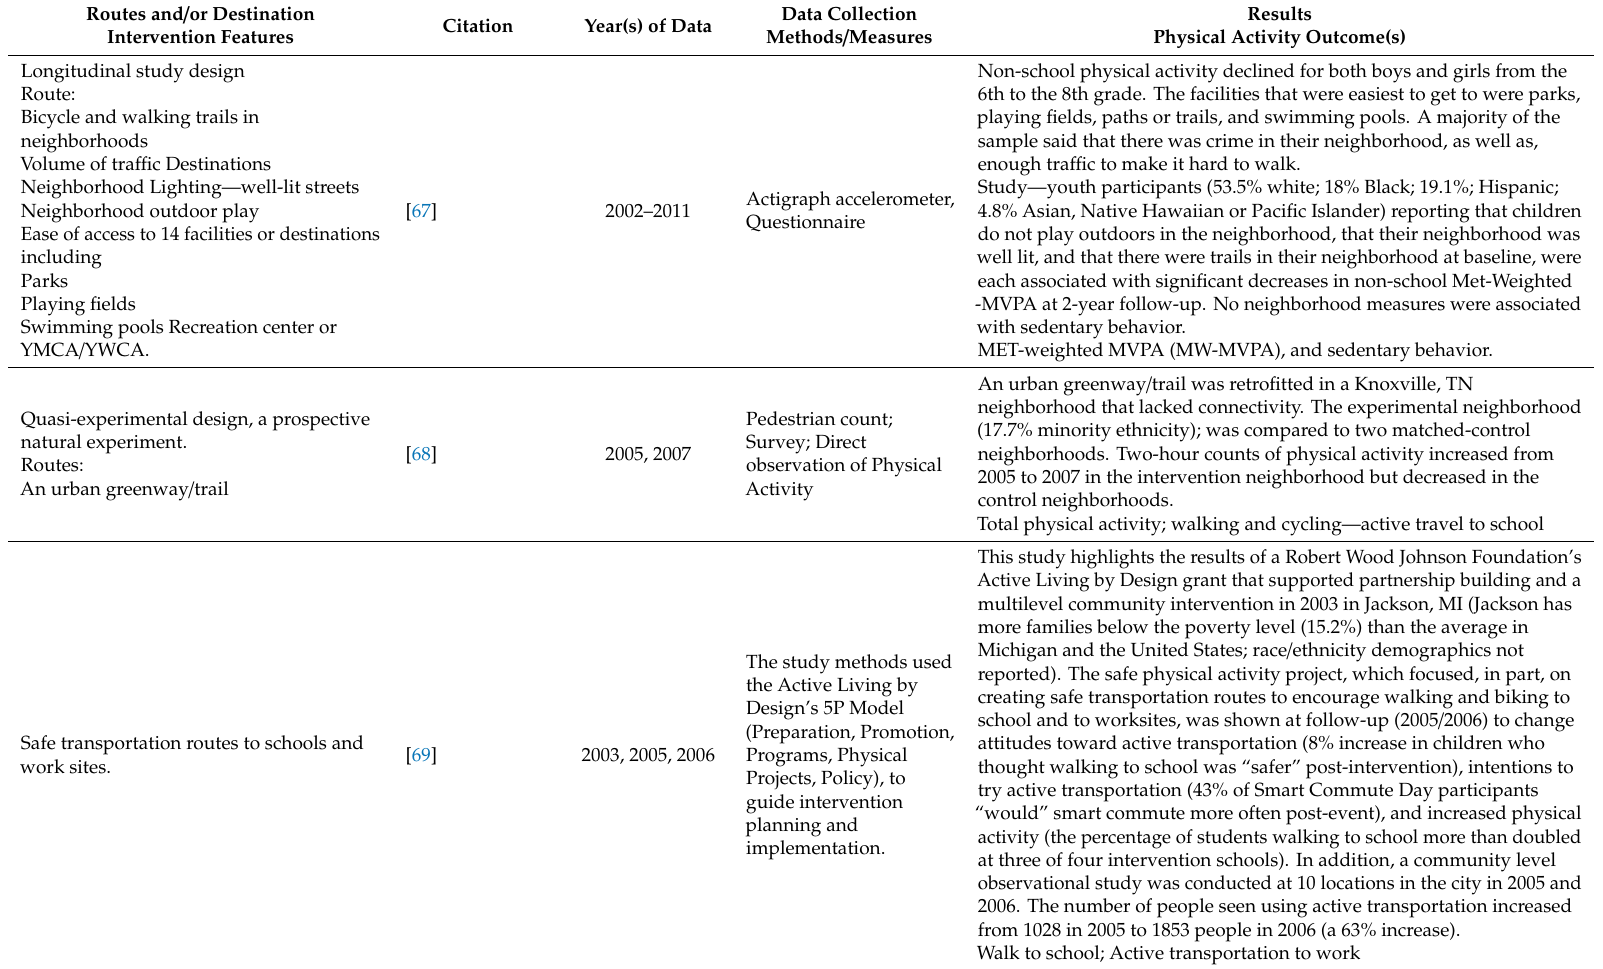
Table A3. Longitudinal or Quasi-Experimental Studies Related to Physical Activity or Trail